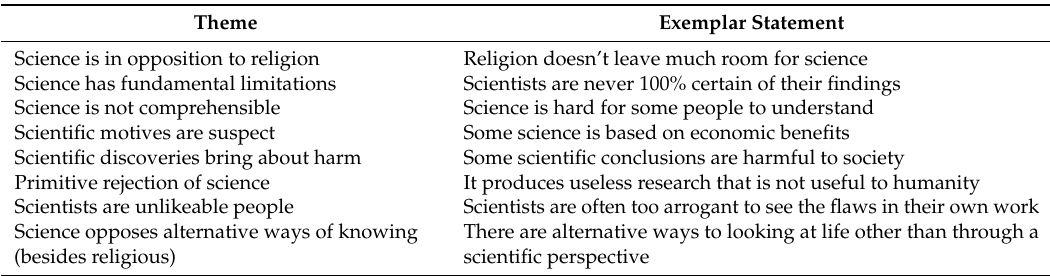
Table 1. Anti-science themes and